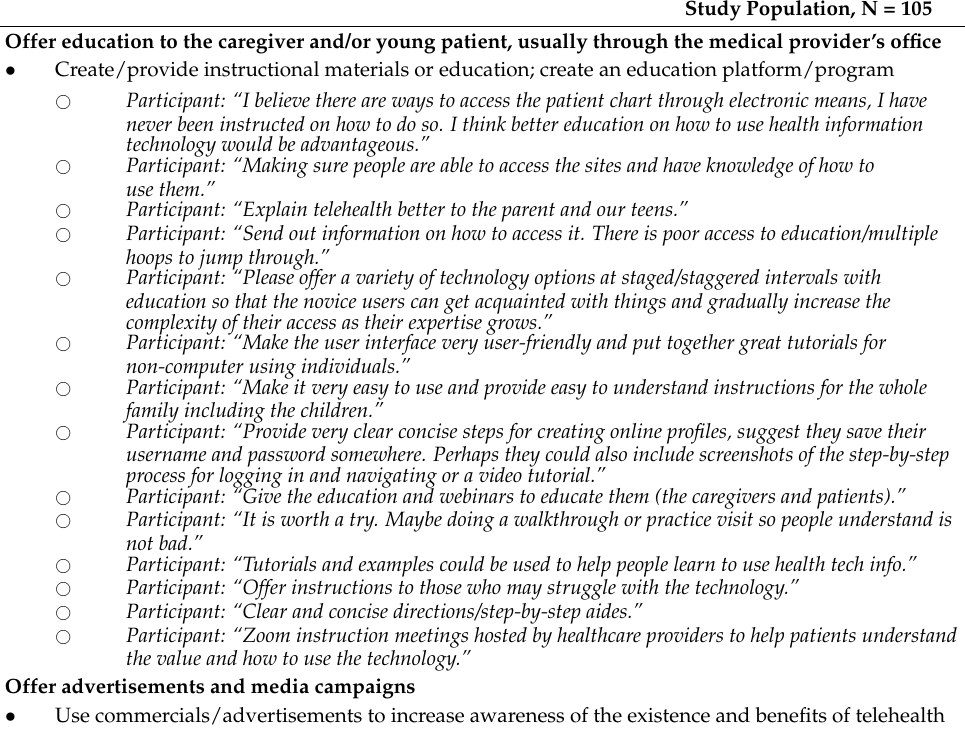
Table 5. Suggestions for offering education, advertisements and media campaigns, a universal plat- form for sharing patient education, and opportunities for young people to be involved in telehealth, along with representative quotes by the caregivers.